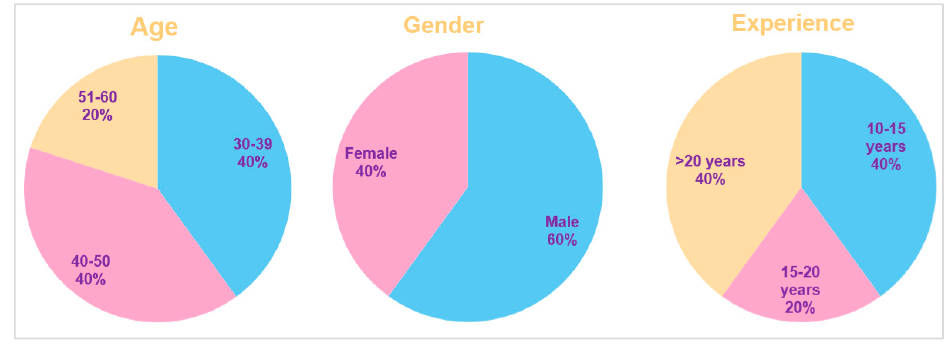
Figure 1. Demographic information of the survey respondents.